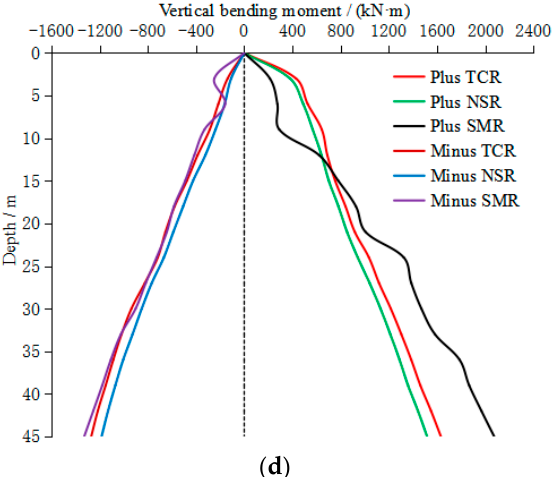
Figure 12. Vertical bending moment results of the circular diaphragm wall at Point A. ( a ) Variation of vertical bending moments obtained by CCSTCM with depth in different working conditions. ( b ) Variation of vertical bending moments obtained by FENSM with depth in different working conditions. ( c ) Variation of vertical bending moments obtained by site monitoring with depth in different working conditions. ( d ) Variation of maximum vertical bending moments with excavation depth.